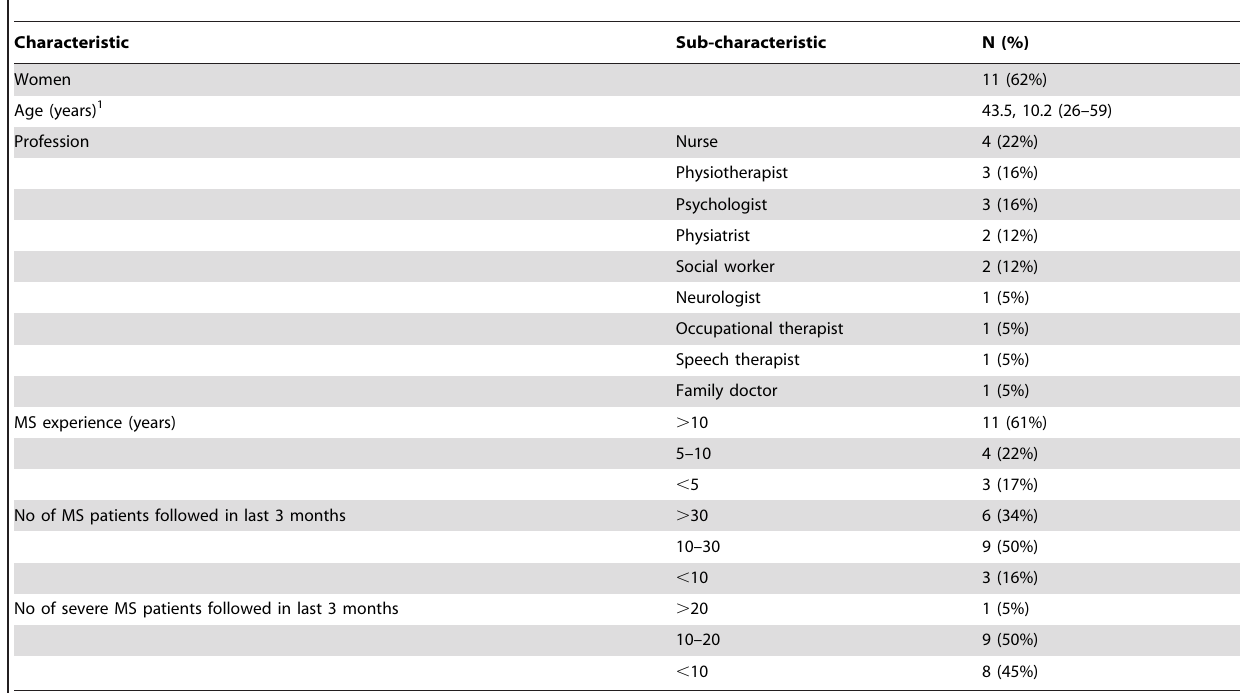
Table 3. Characteristics of the 18 health professionals who participated in the focus group meetings.